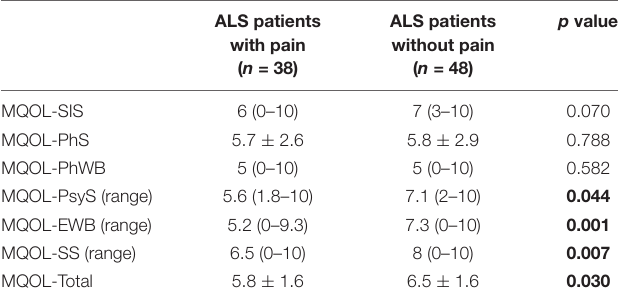
TABLE 2 | Interference of pain on quality of life in amyotrophic lateral sclerosis (ALS) patients with pain or without pain.